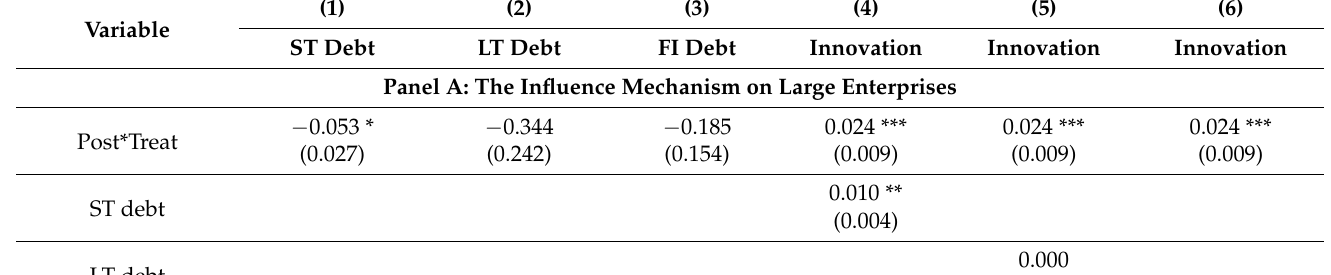
Panel B: The Influence Mechanism on Small